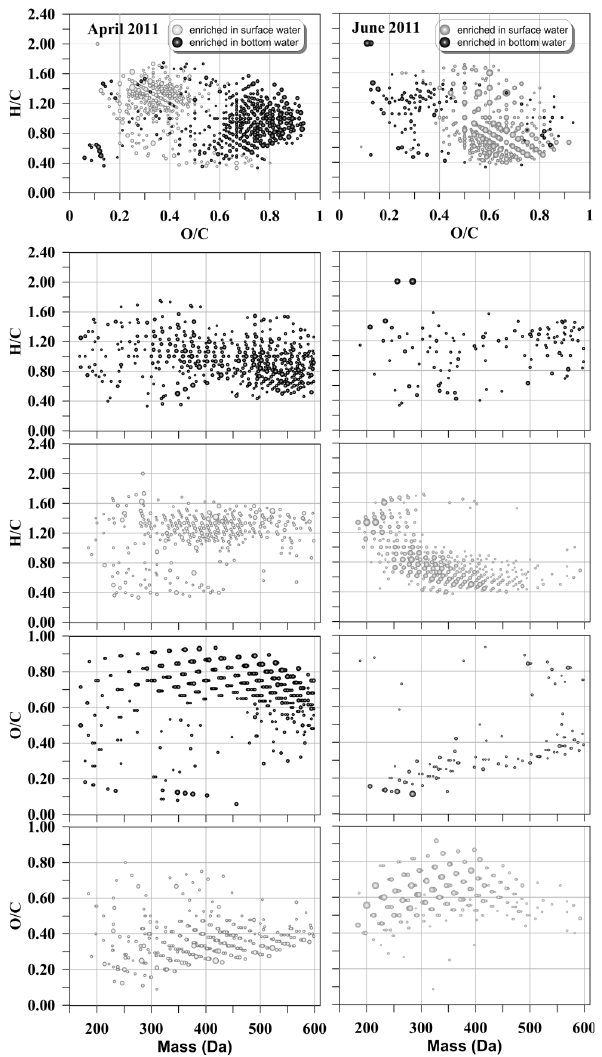
Fig. 6. Van Krevelen, H/C and O/C versus mass diagrams of rela- tive differences in mass peak abundances between surface and deep SPE-DOM in April and June 2011. Note: the bubbles represent the relative abundances greater than 10%.